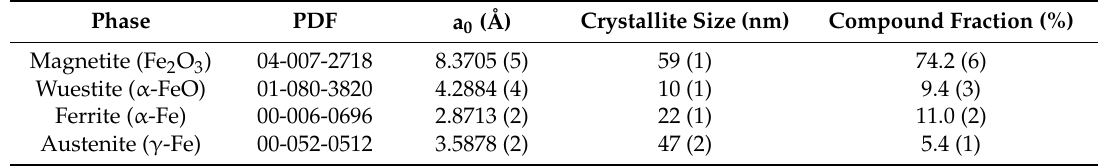
Table 1. Data of the Rietveld analysis performed on XRD profile of the studied